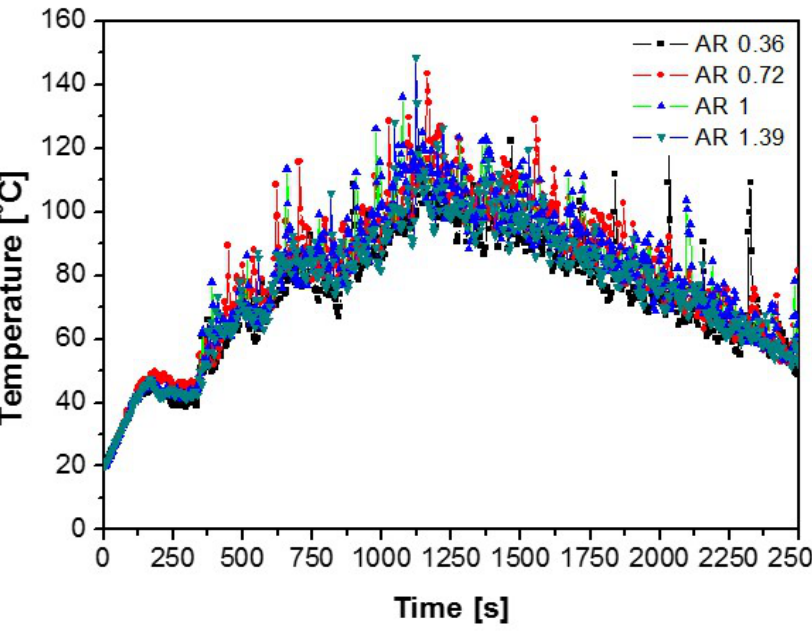
Figure 12. Temperature changes over time at the height of 1.7 m.